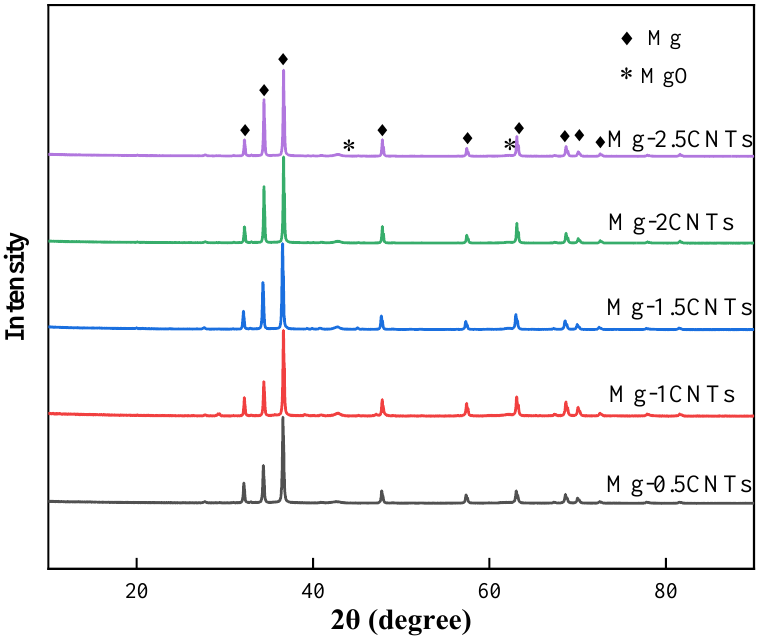
Figure 4. XRD patterns of sintered CNT/Mg composites with different contents of CNTs. Figure 5 shows the metallographic microstructure of the CNT/Mg composites with different CNT contents. The grain size and morphology of the matrix show little change with the increase in CNT content. However, when the CNT content is higher, there are more black spots in the microstructure. The black spots measure 2 – 4 μm in size in the 2.5% CNT/Mg composite. The size is similar to that of the CNT aggregates in mixed powders (Figure 3). Hence, it can be inferred that these black spots are CNT clusters.